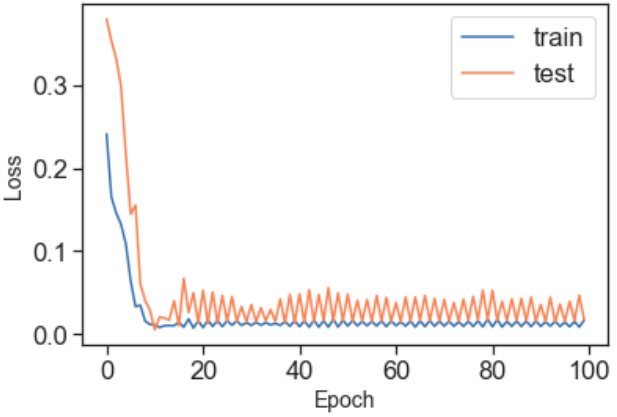
Figure 9. Model loss for the training process.